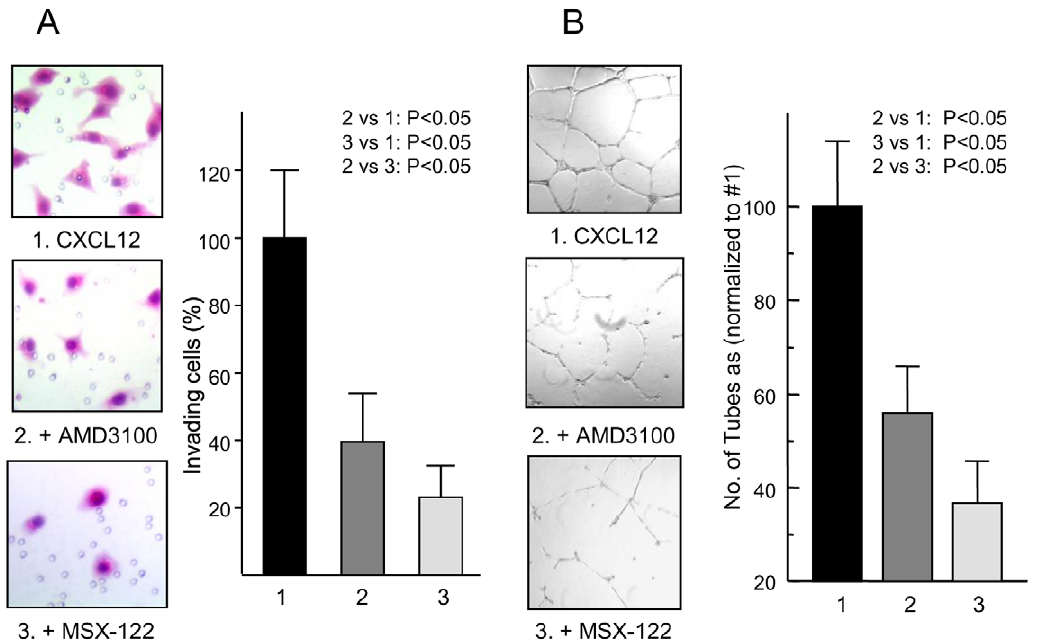
Figure 2. MSX-122 blocks invasion and angiogenesis invitro . (A) Micrographs of Matrigel invasion assay induced by CXCR4/CXCL12-mediated interaction using MDA-MB-231 cells in the presence of anti-CXCR4 compounds. (B) Representative micrographs of the endothelial tubular network formation in the presence of anti-CXCR4 compounds. HUVECs formed excellent tubular networks in the presence of CXCL12 ( # 1), but poor tubular networks when CXCL12 was blocked by prior treatment with 100 nM of AMD3100 ( # 2) or MSX-122 ( # 3). The results are summarized in a graph in the right panel.